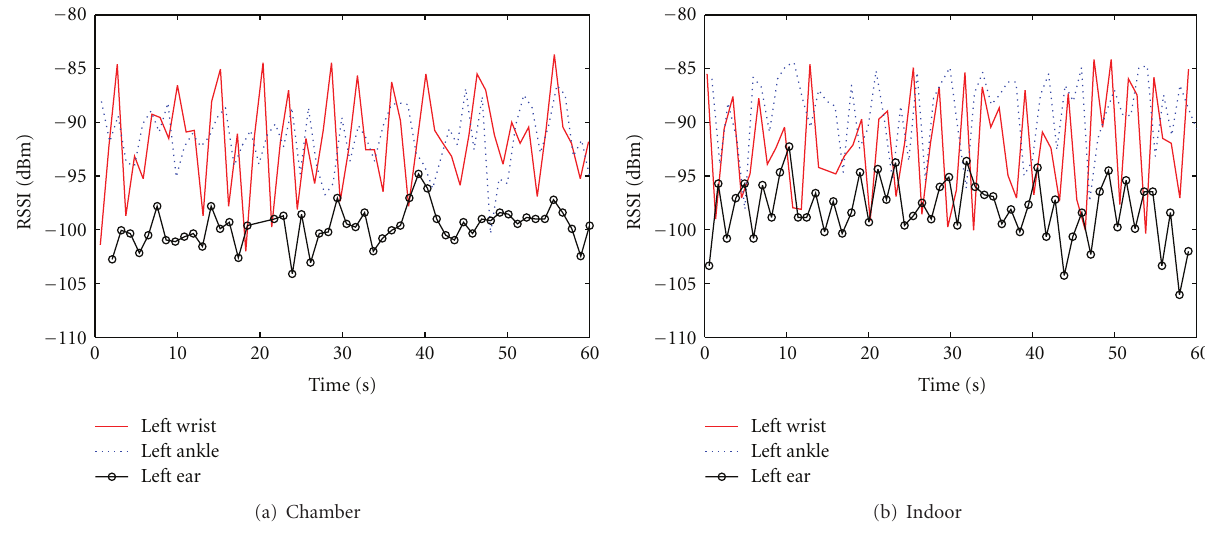
Figure 11: Comparison of RSSI level for three di ff erent on-body channels as left wrist, left ankle, and left ear when human subject was walking 5 steps ahead and 5 steps backward measured in the (a) chamber, (b) indoor.